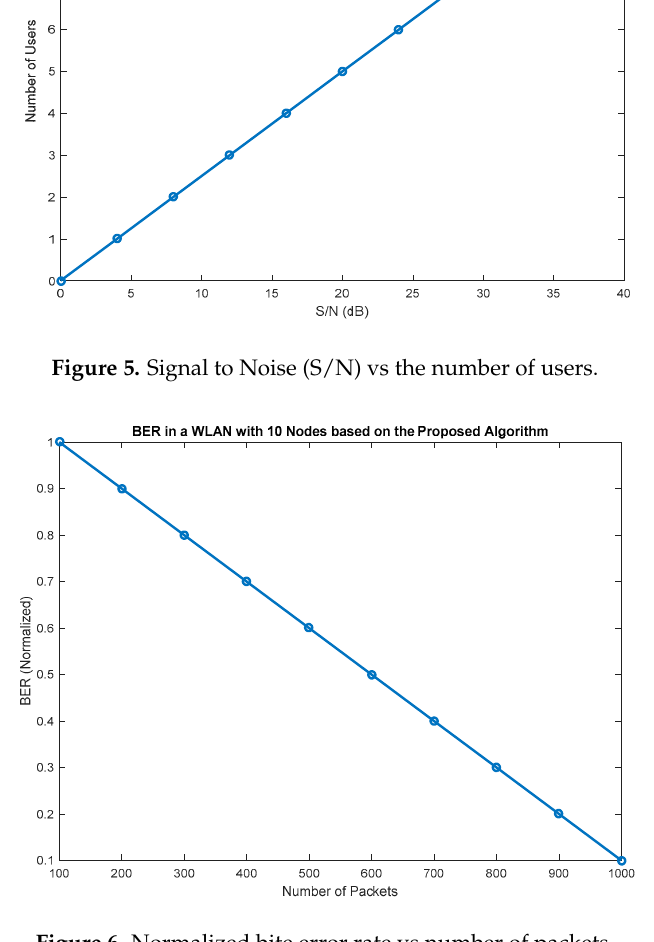
Figure 6. Normalized bite error rate vs number of packets.